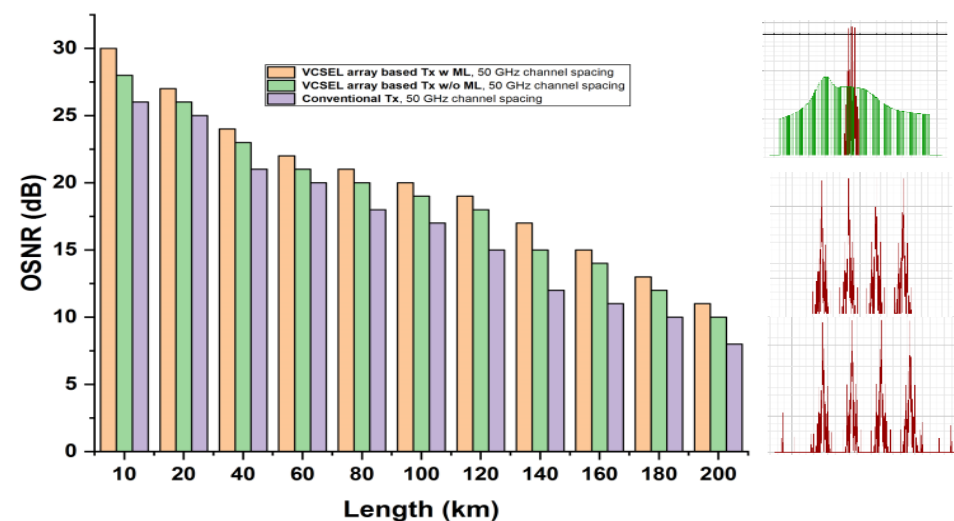
Figure 6. Transmission range performance of proposed OWN vs. OSNR VSEL with ML and without ML at 50 GHz channel